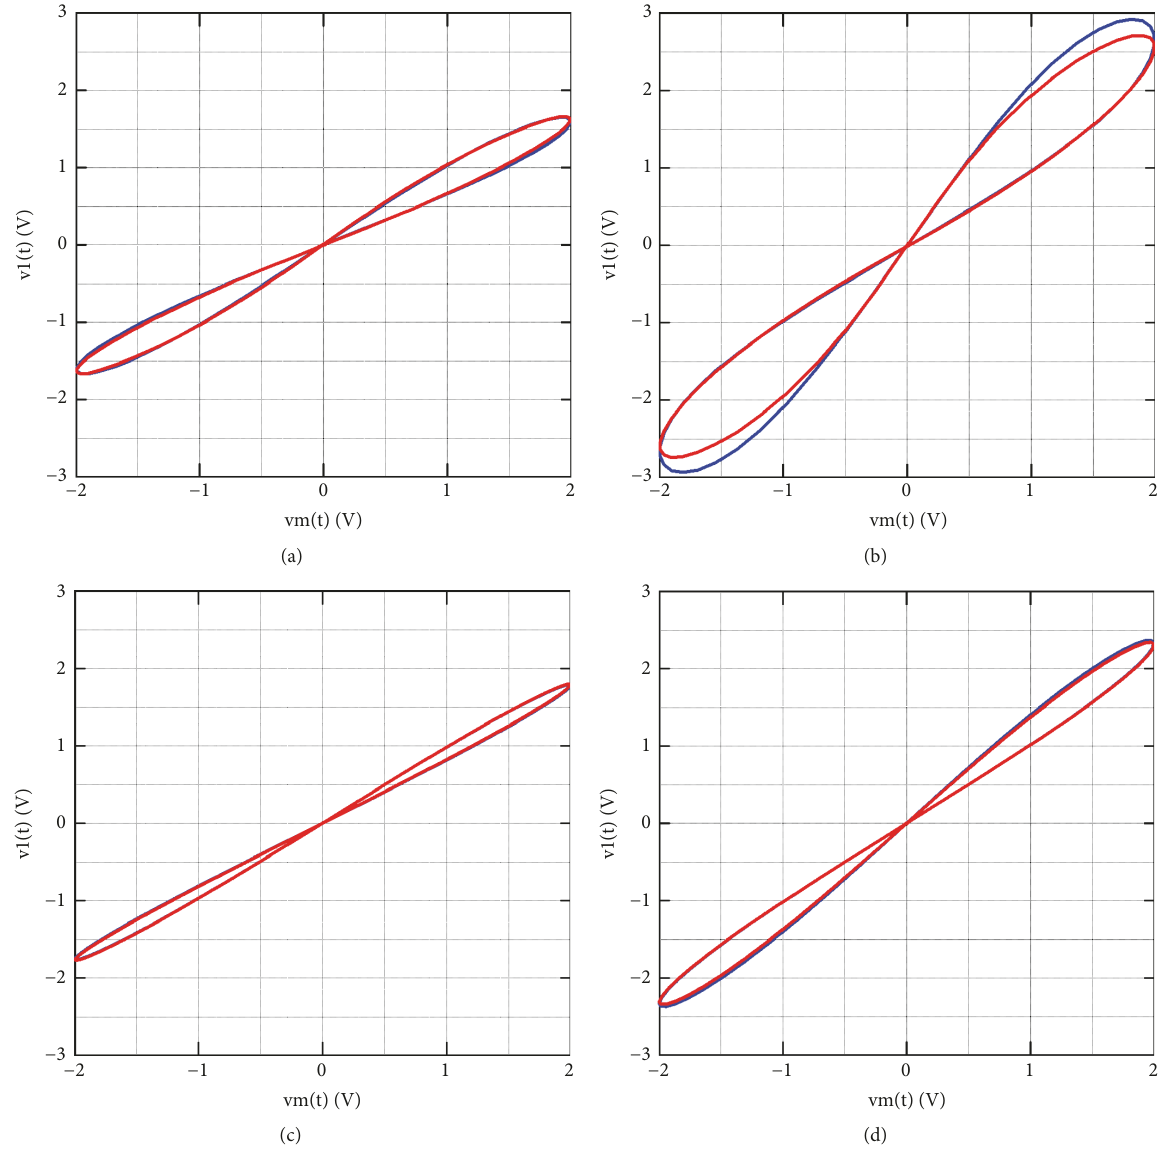
Figure 5: Comparing the frequency-dependent pinched hysteresis loops of the flux-controlled floating memristor (blue line) and fracmemristor (red line): (a) incremental mode, (b) decremental mode, and for the charge-controlled grounded memristor (blue line) and fracmemristor (red line): (c) incremental mode and (d) decremental